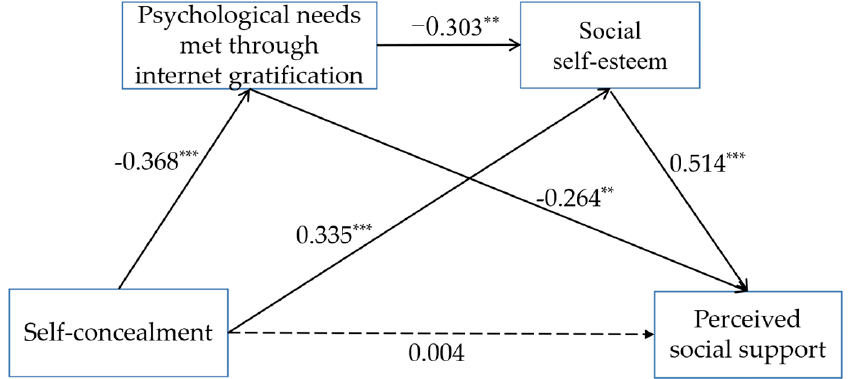
Figure 2. The serial mediation model with ‘psychological needs met through internet gratification’ and social self-esteem’ as mediators of the linkage between ‘self-concealment’ and ‘perceived social support’. Note: ** p < 0.01, *** p < 0.001.